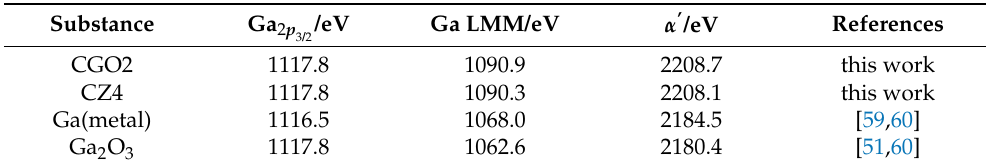
Table 5. Binding energies for the Ga 2 p XPS CL peaks and kinetic energies for the Ga L 3 M 4,5 M 4,5 3/2 Auger peaks, and the modified Auger parameters α (cid:48) for CGO2 and various gallium materials in eV ( ± 0.1